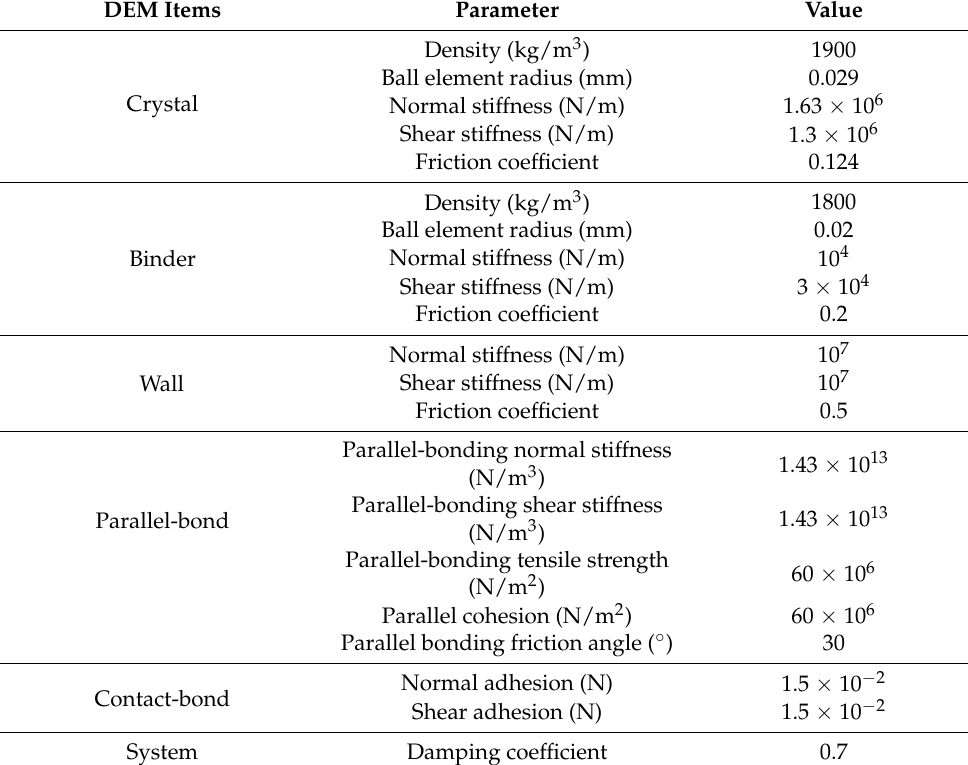
Table 1. DEM parameters of the elementary